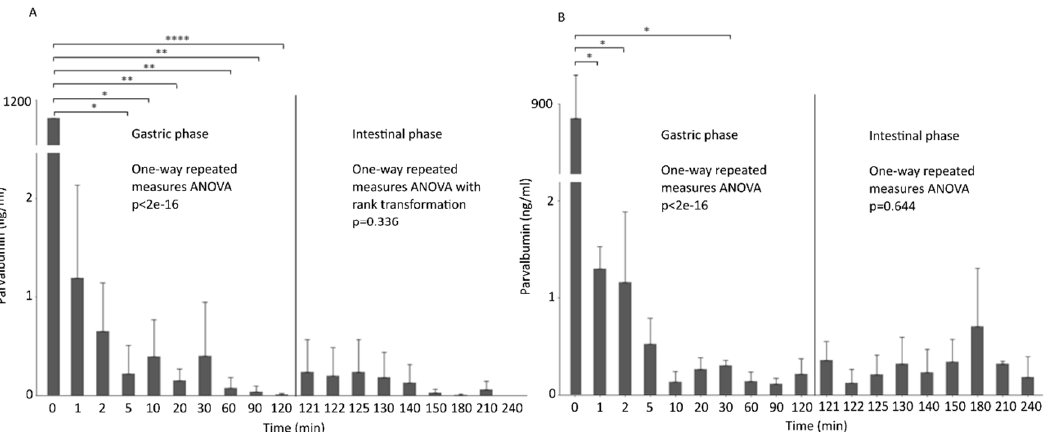
Figure 3. Bar plot of in vitro simulation of the gastrointestinal tract of muscle proteins ( n = 3) from European seabass ( A ) and gilthead seabream ( B ). Parvalbumin was quantified using a sandwich ELISA with antibodies against the analyzed fish species. Asterisks indicate significant differences by paired t-test with Bonferroni correction (* p < 0.05, ** p < 0.01, **** p < 0.0001). X -axis represents time (min) and y -axis the measured parvalbumin (ng/mL).